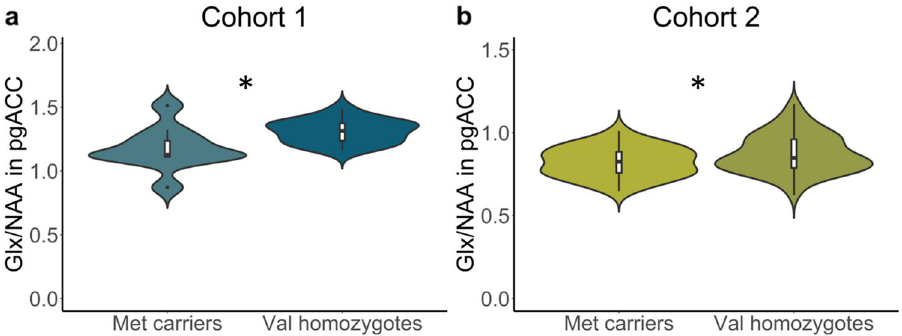
Figure 1. BDNF Val66Met effects on pgACC Glx/NAA. Violin plots represent distributions of Glx/NAA values corrected for the effects of confounders (cohort 1: age, gray matter tissue proportion; cohort 2: age, gray matter tissue proportion and gender). ( a ) Results of cohort 1 (3 T, n = 26). ( b ) Results of cohort 2 (7 T, n = 97). *P <